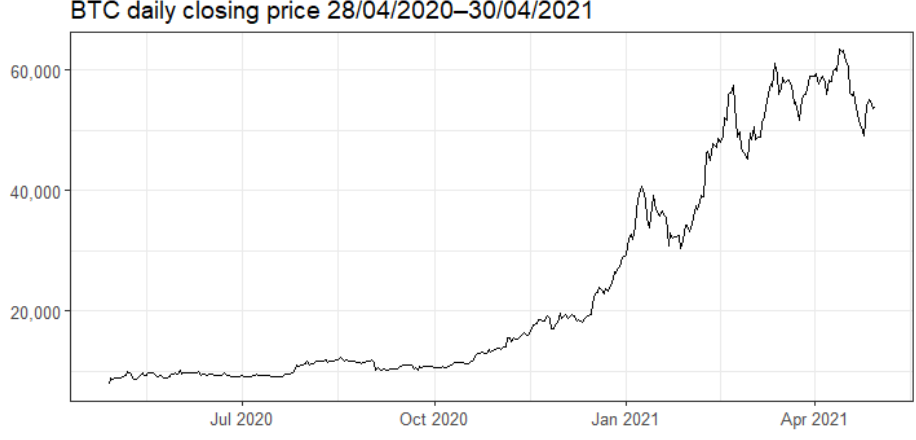
Figure 1. Bitcoin’s daily closing price 28 April 2020–30 April 2021.